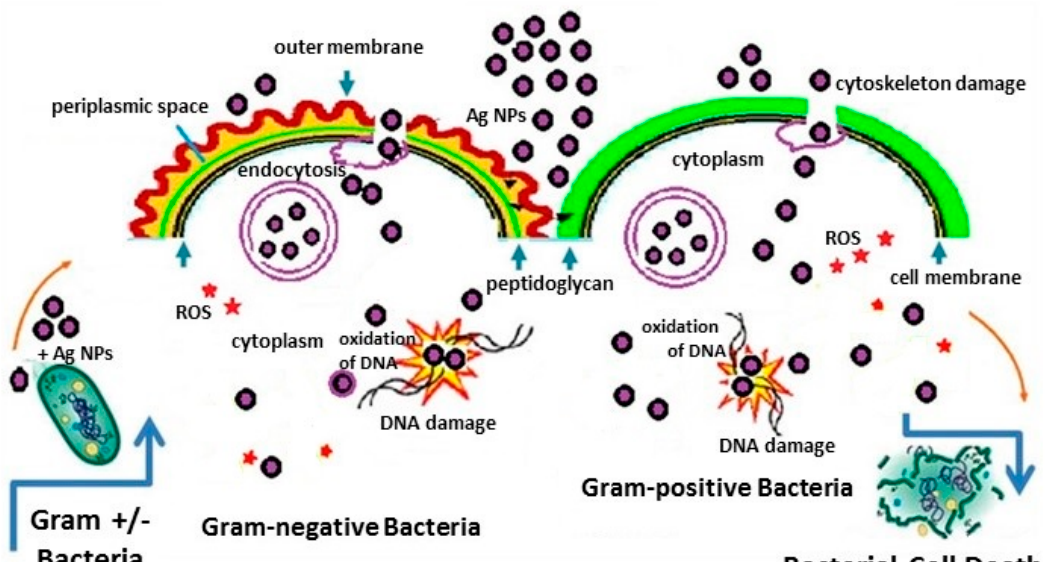
Figure 4. Schematic diagram of bactericidal activity of Ag NPs on Gram-positive and Gram-negative bacteria. Reproduced with permission from Springer [24]. Ag NPs adhesion to microbial cells, penetration inside the cells, ROS and free radical generation, and modulation of microbial signal transduction pathways have been recognized as the most prominent modes of antimicrobial action [13].